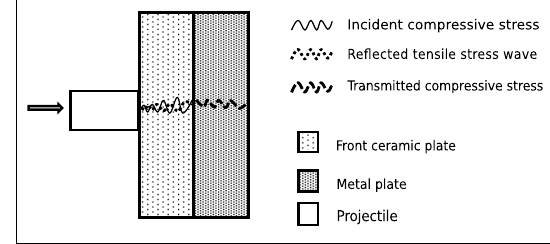
Figure 2. Representation of stress waves in multi layered armour